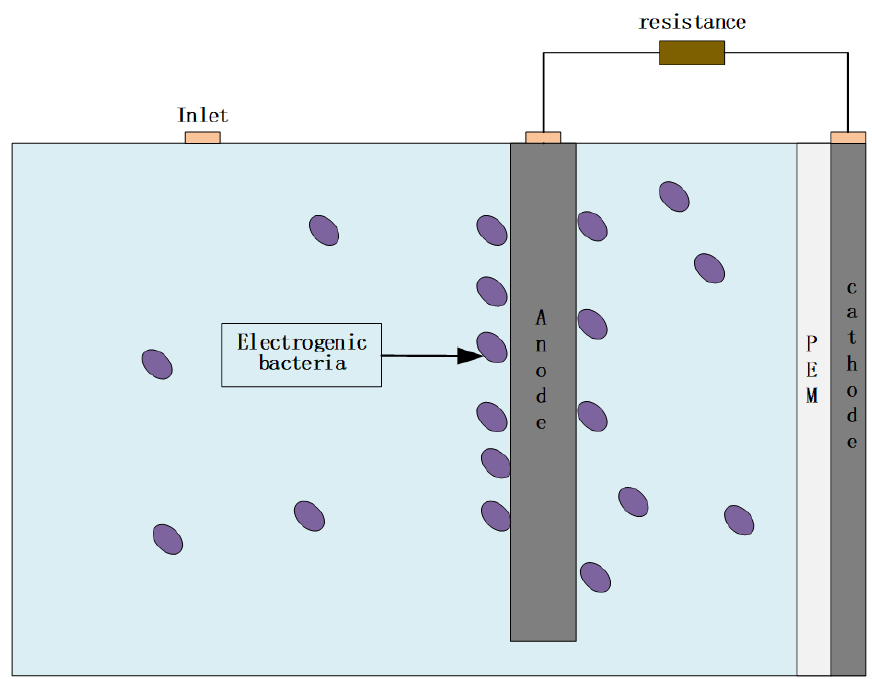
Figure 1. Schematic diagram of the single-chamber MFC